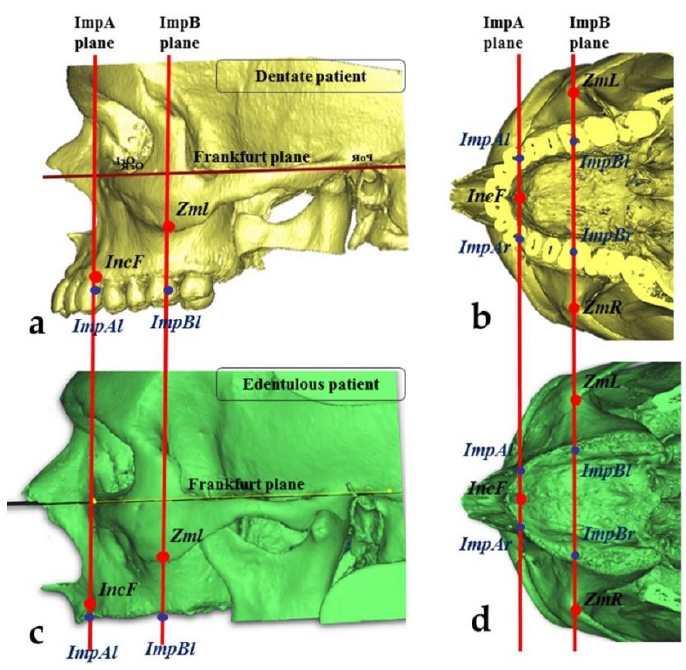
Figure 1. Identification of the ideal implant emergences corresponding to the positions of the lateral incisors/canines (for anterior zygomatic implants) and second premolars/first molars (for posterior implants). ( a ) Lateral view of a dentate patient; ( b ) occlusal view of a dentate patient; ( c ) lateral view of a edentulous patient; ( d ) occlusal view of a edentulous patient .